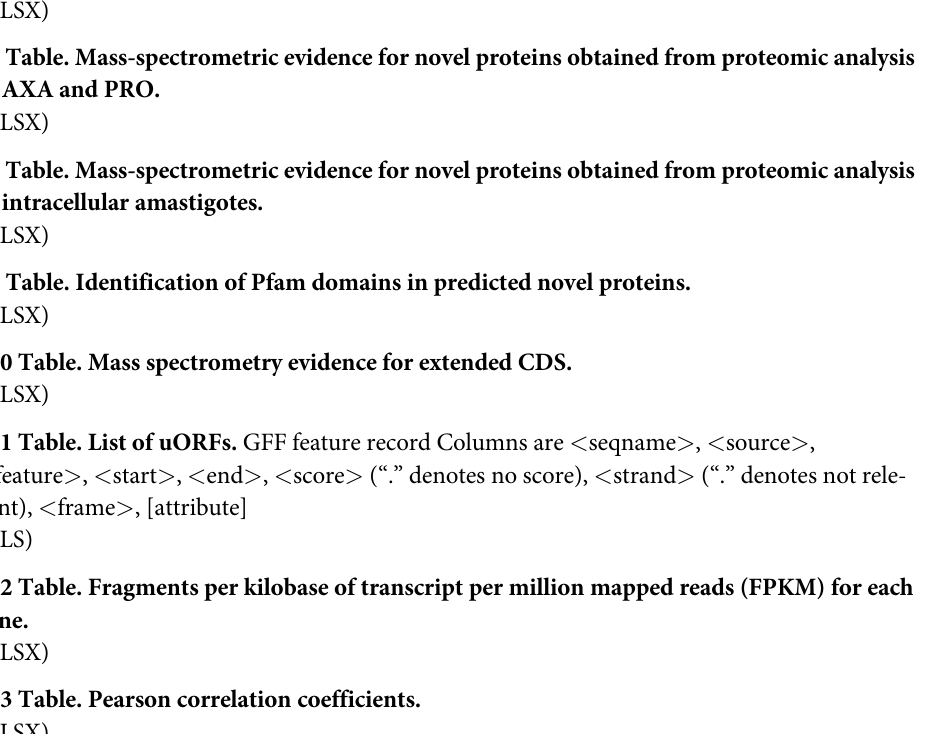
S12 Table. Fragments per kilobase of transcript per million mapped reads (FPKM) for each gene. S13 Table. Pearson correlation coefficients. S14 Table. List of genes in the top percentile of FPKM for AMA, AXA and PRO. S15 Table. Differential expression analysis PRO vs. AMA. S16 Table. Differential expression analysis PRO vs. AXA. S17 Table. Differential expression analysis AXA vs. AMA. S18 Table. Comparison of RNA-seq data with published northern blot data for L . mexicana transcripts. S19 Table. GO term and pathway enrichment summary. S20 Table. Pfam-A and Pfam-B enrichment summary. S21 Table. Orthogroup